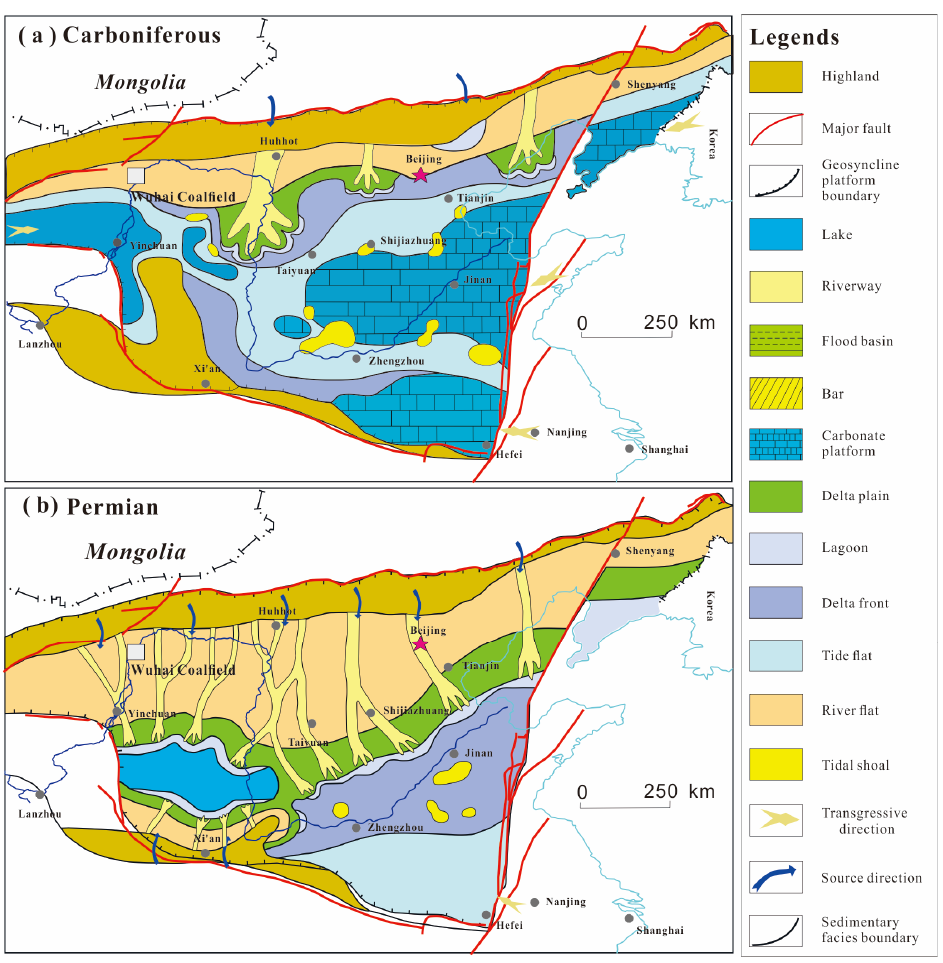
Figure 4. Overview diagram showing paleogeography of the whole North China Block from Car ‐ boniferous ( a ) to Permian ( b ) (Modified from Shao et al. [4]).